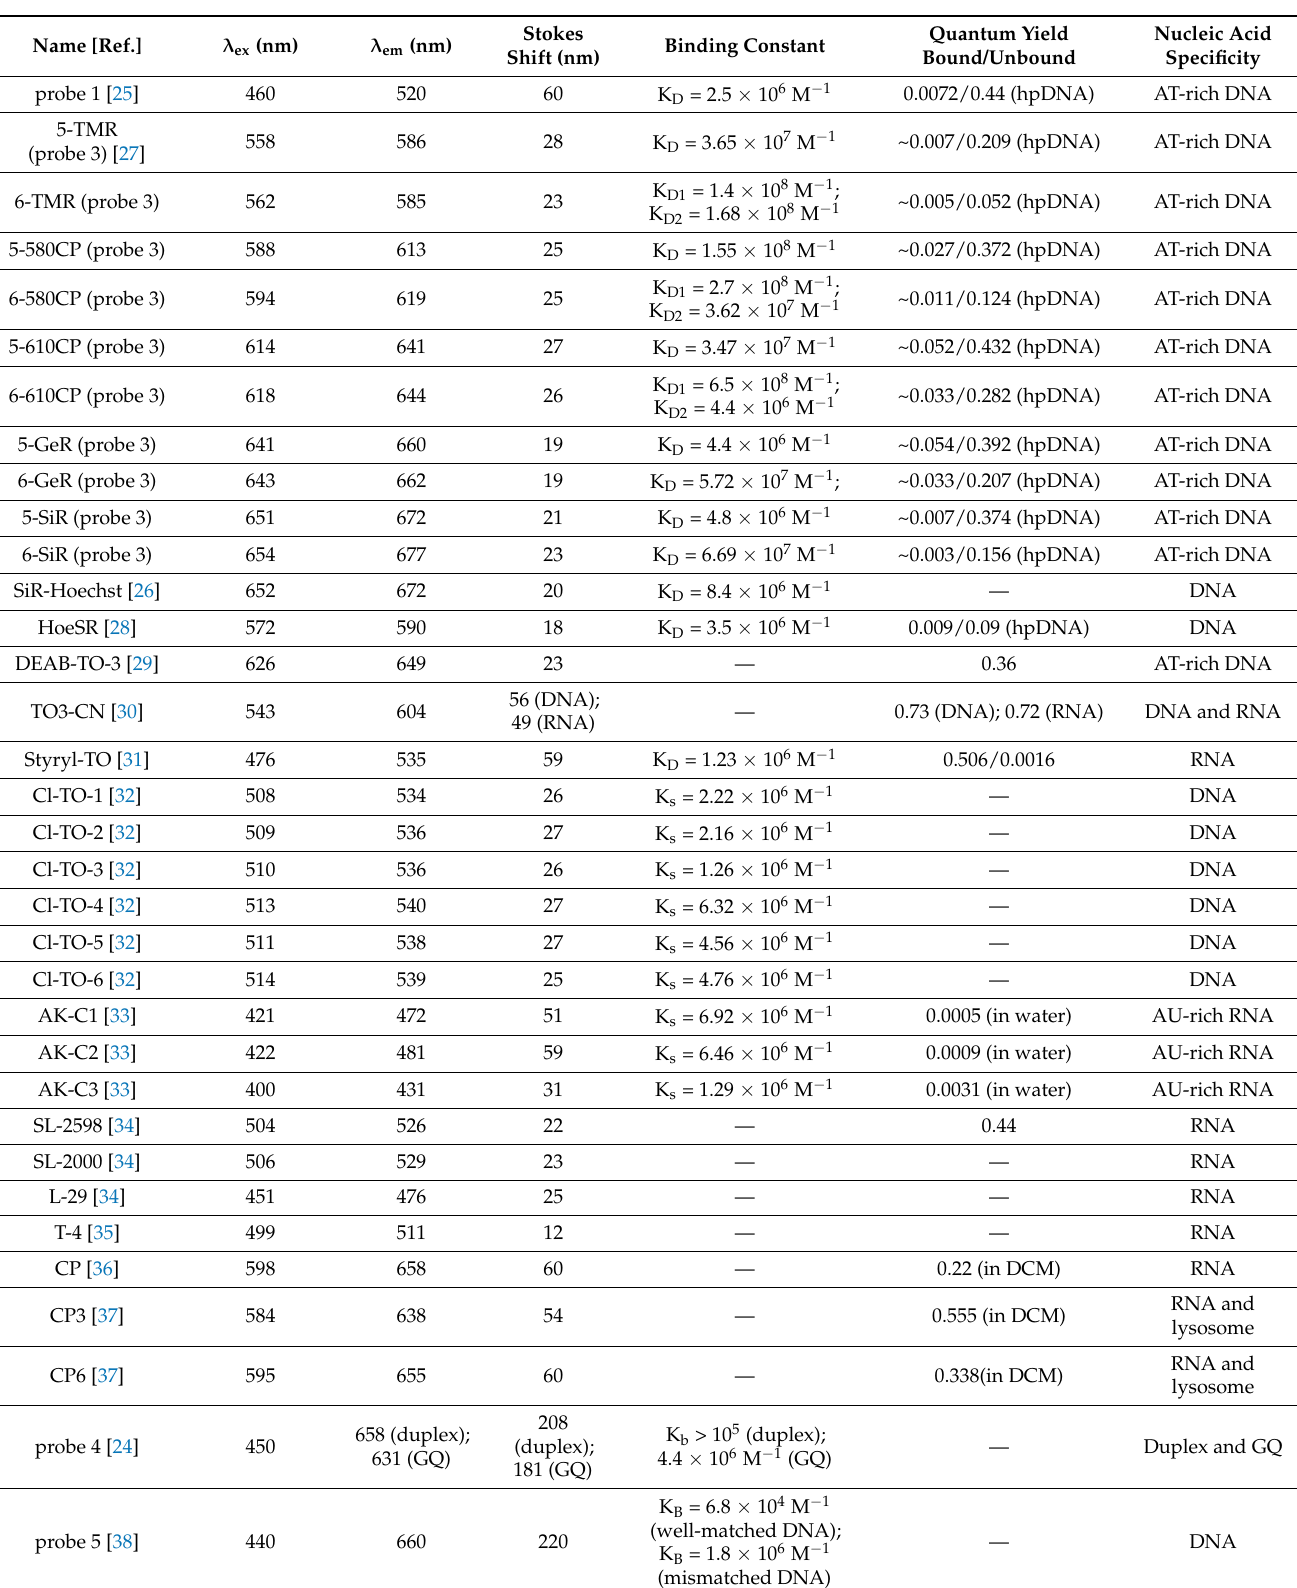
Table 1. Summary of the characteristic properties of the nucleus-targeted fluorescent probes for nuclear